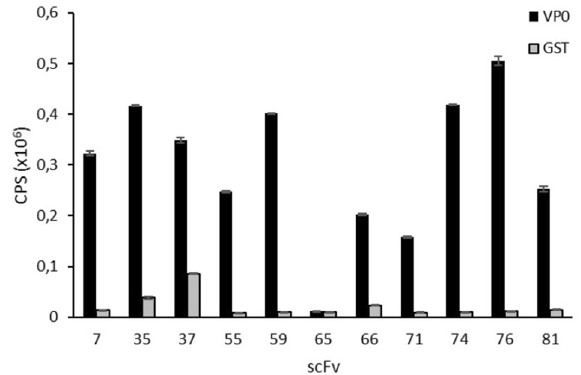
Figure 1. Time-resolved fluoroimmunoassay of selected scFv clones. Based on CDR-H3 sequences, a total of 11 clones were selected for secondary screening against VP0-GST and GST in a TRF-assay using europium chelate. In the assay, His-tag purified scFv clones expressed as a fusion to bacterial alkaline phosphatase, His-tag and FLAG tag were bound to biotinylated VP0-GST and biotinylated GST on 96 well streptavidin microtiter plate. Bound scFv-AP was detected with polyclonal Eu-labelled anti-alkaline phosphatase antibody and time-resolved fluorescence from europium was measured with Victor 3 multilabel counter. The Y-axis represents the europium counts per second. The X-axis represents the different clones screened based on different CDR-H3